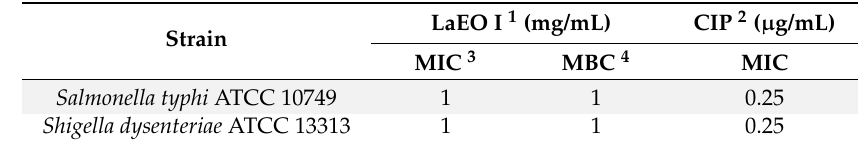
Table 2. MIC and MBC concentrations of LaEO I and ciprofloxacin on Salmonella typhi and Shigella dysenteriae